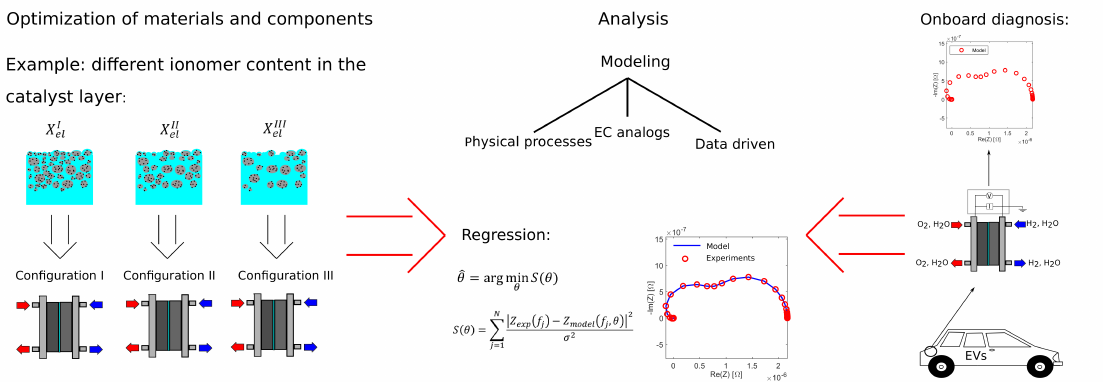
Figure 2. Schematic of the different uses of electrochemical impedance spectroscopy (EIS) or a generic frequency response analysis (FRA) technique discussed in this